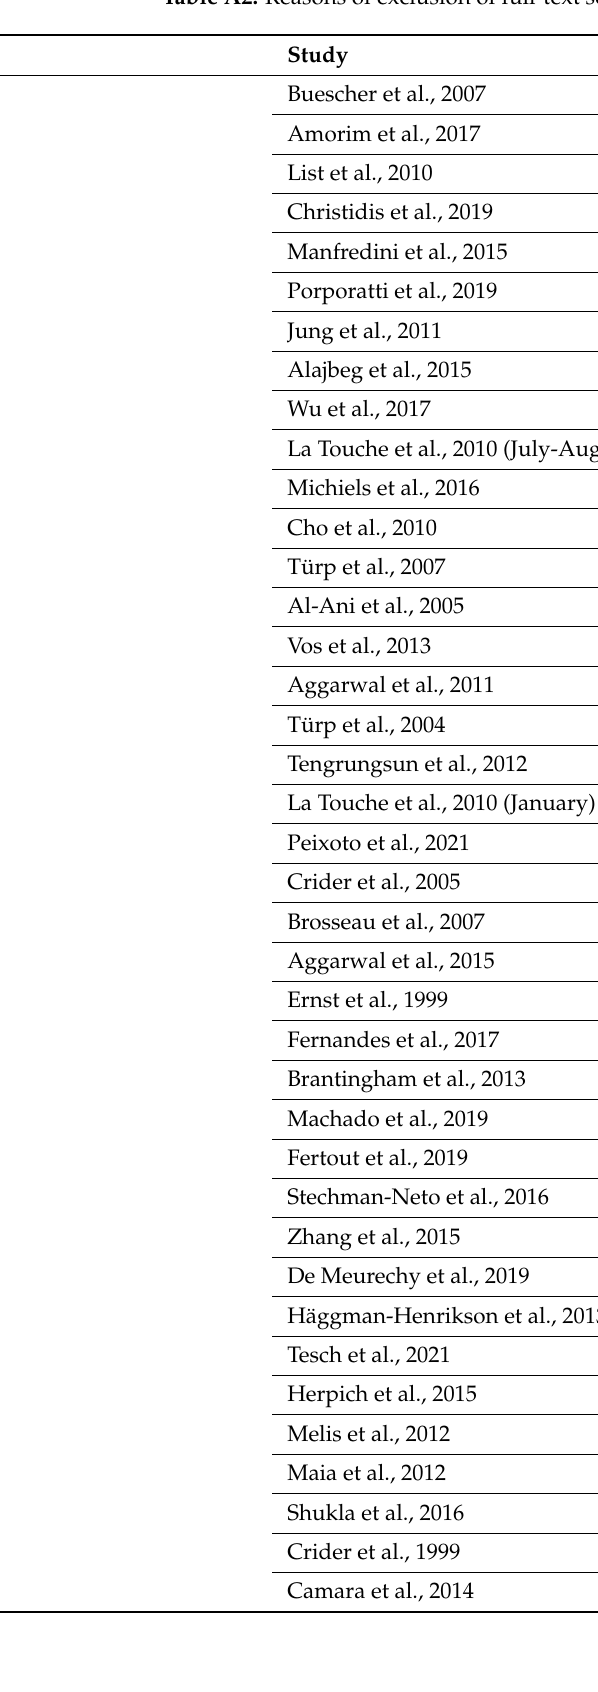
Table A2. Reasons of exclusion of full-text screening